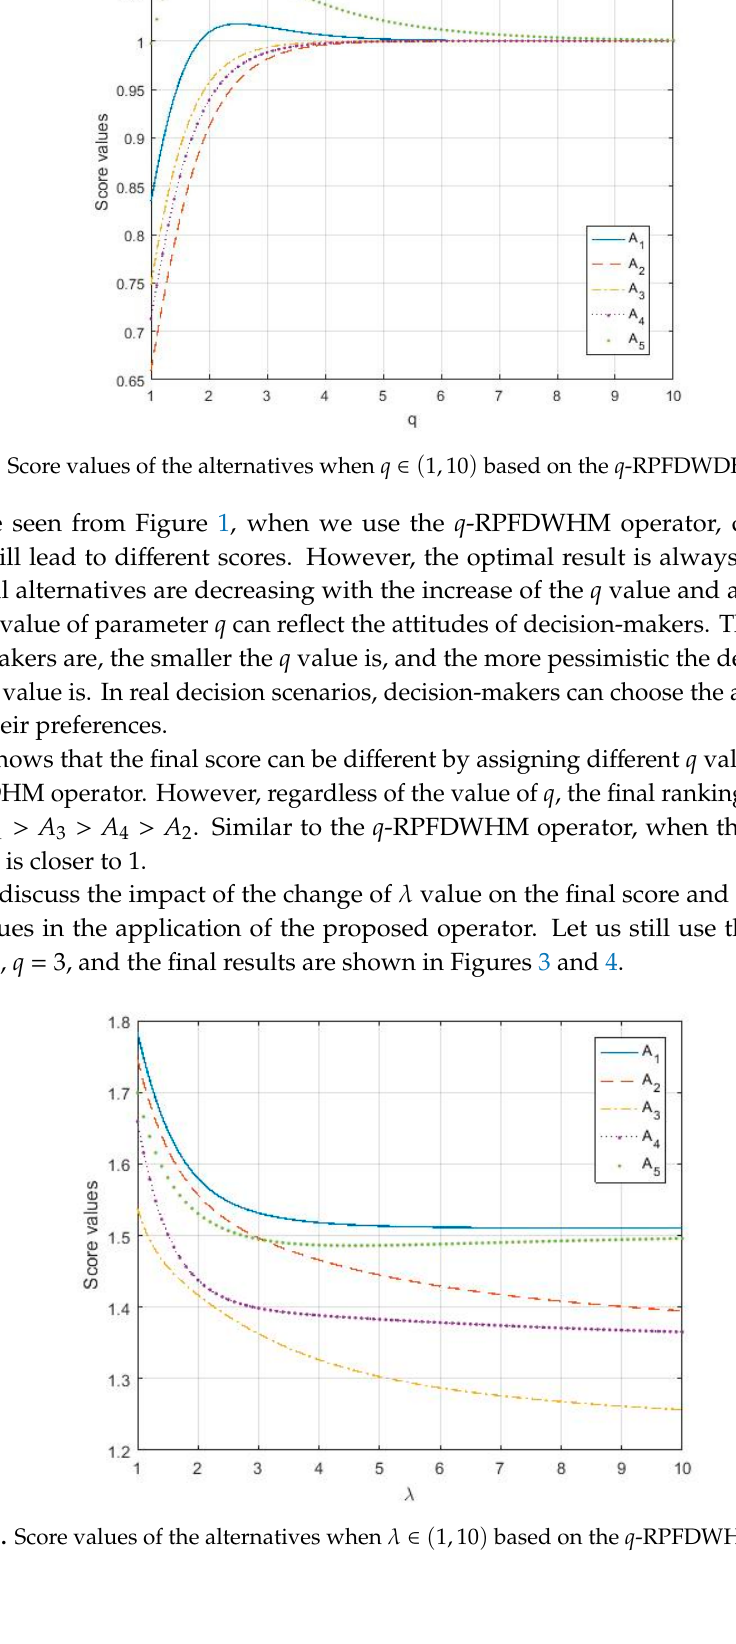
Figure 3. Score values of the alternatives when